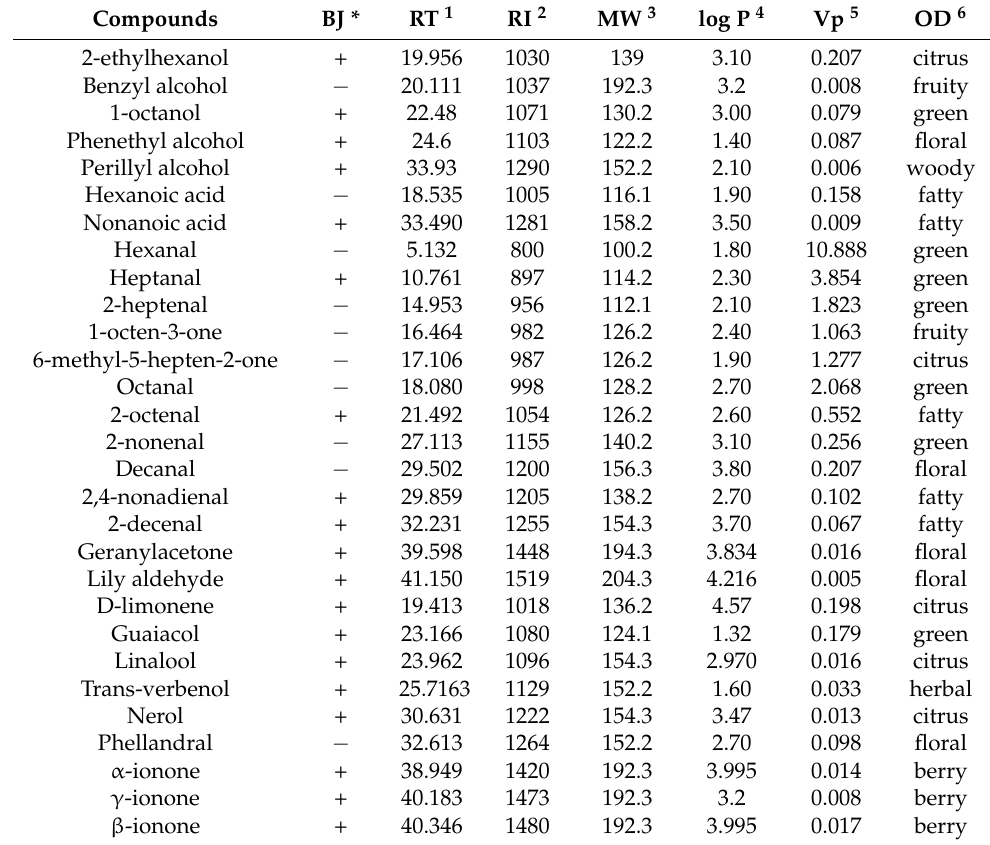
Table 5. Volatile compounds detected in blackberry juice and citrus fiber-blackberry cream